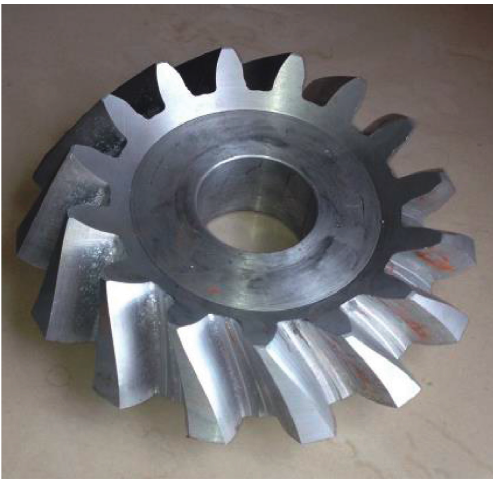
Figure 11: Equal-base circular gear after machining.